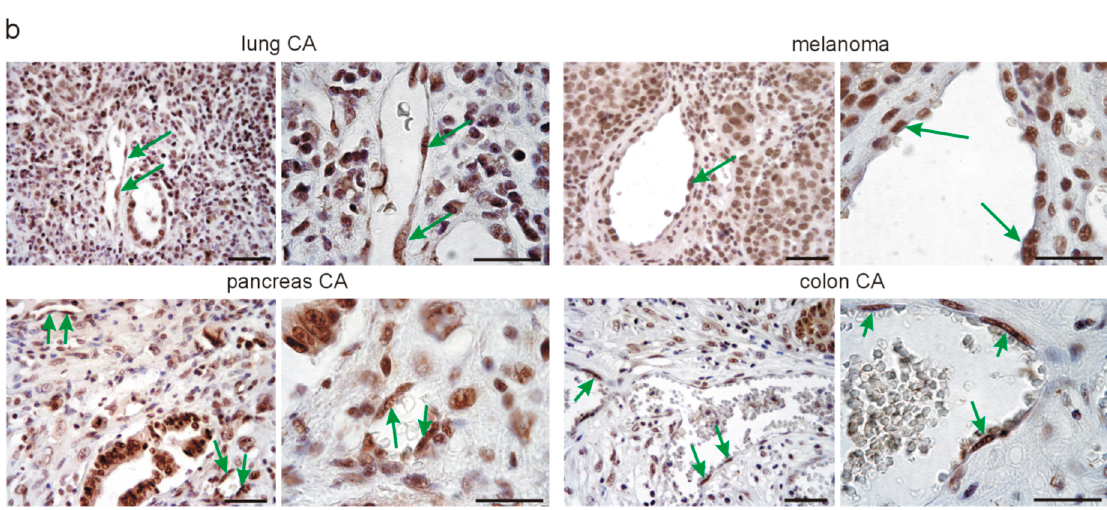
Figure 2. Srsf1 expression in different healthy adult mouse tissues and different human tumor types. ( a ) Representative examples of Srsf1 immunostaining (DAB substrate, brown) in skin, lung, heart, pancreas, kidney, ovary, brain, and liver sections of adult mice ( n = 3 each). Nuclei were counterstained with hematoxylin (blue). For each organ, one example and a higher magnification are shown. Note the nuclear localization of Srsf1 in different cell types of the organs. Green arrows point to vascular endothelial cells in the different organs, which are rarely Srsf1-positive. ( b ) Representative examples of SRSF1 expression in human lung cancer, melanoma, pancreas, and colon cancer sections ( n = 10 each). Immunostaining for SRSF1 was visualized with DAB substrate (brown) and the nuclei counterstained with hematoxylin (blue). Note in human tumors the high nuclear SRSF1 expression in tumor and endothelial cells. Green arrows point to endothelial cells. Scale bars indicate 50 µ